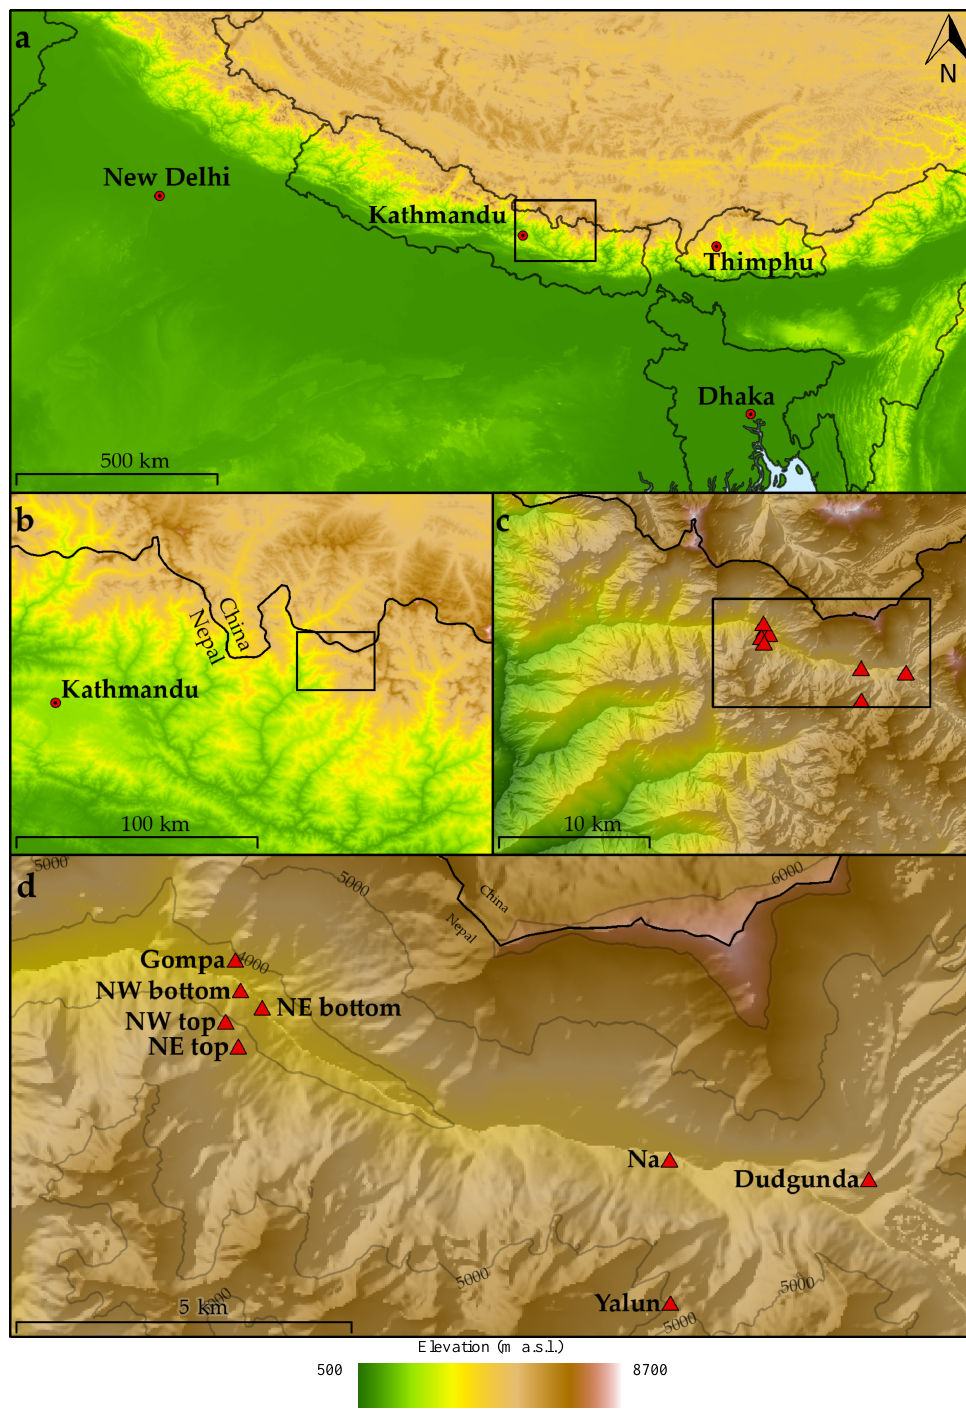
Figure 1. Network of automated weather stations (AWSs) installed in the Rolwaling Valley, Nepal. Source: ( a , b ) ESRI [58]; ( c , d ) ALOS (AW3D30) by JAXA